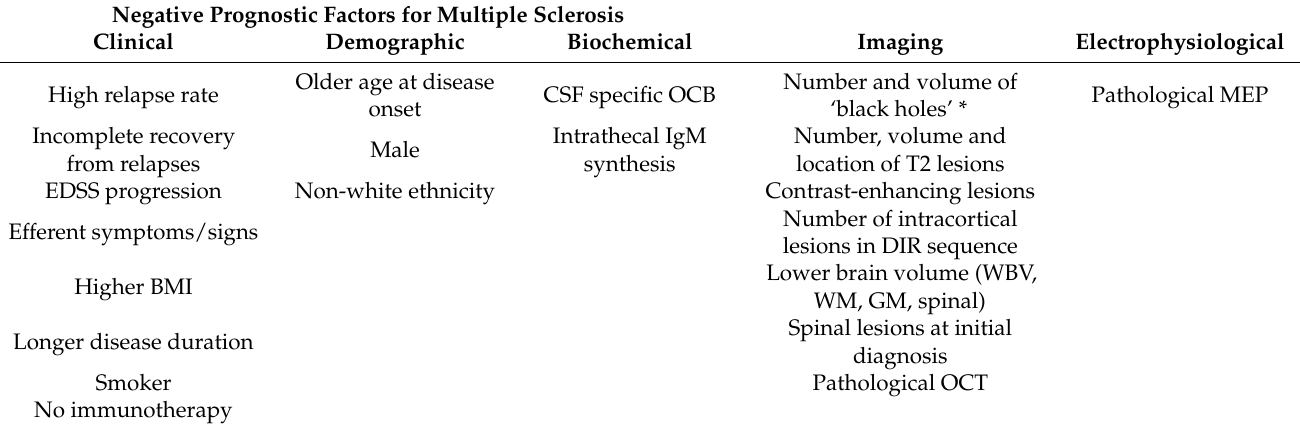
Table 1. Negative prognostic factors for multiple sclerosis (adapted according to